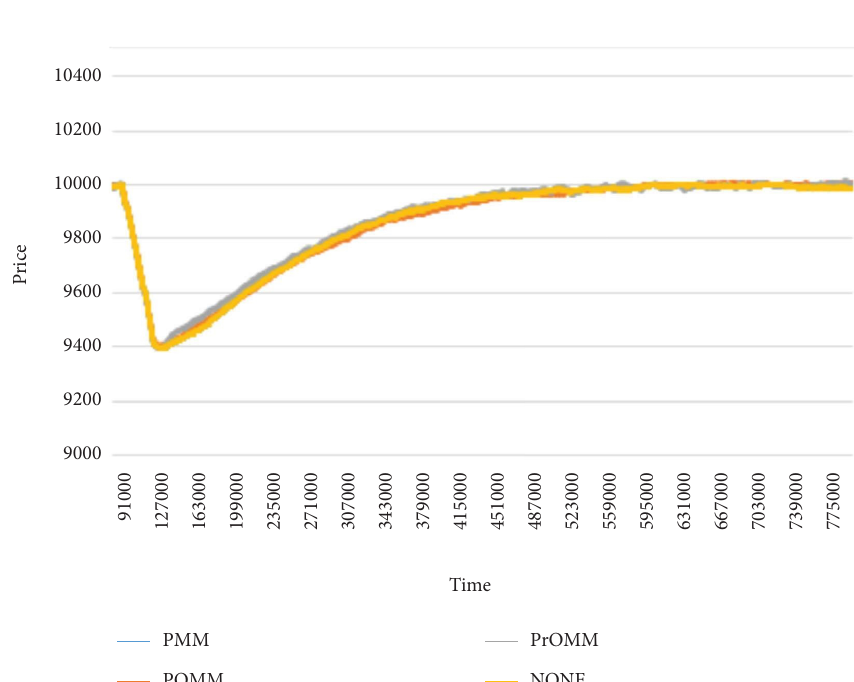
Figure 2: Price transitions of the unstable market.